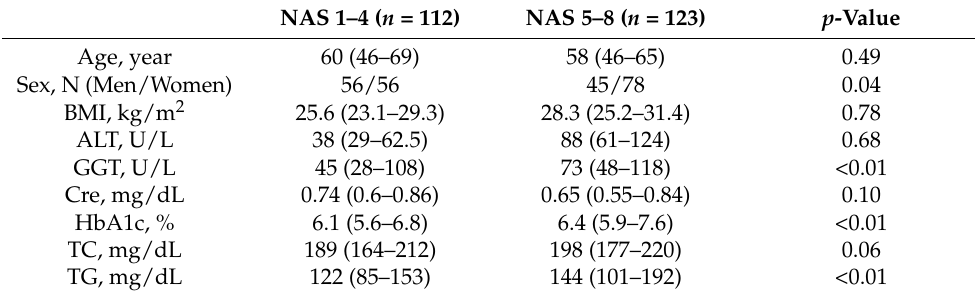
Table 3. Characteristics (low NAS vs. high